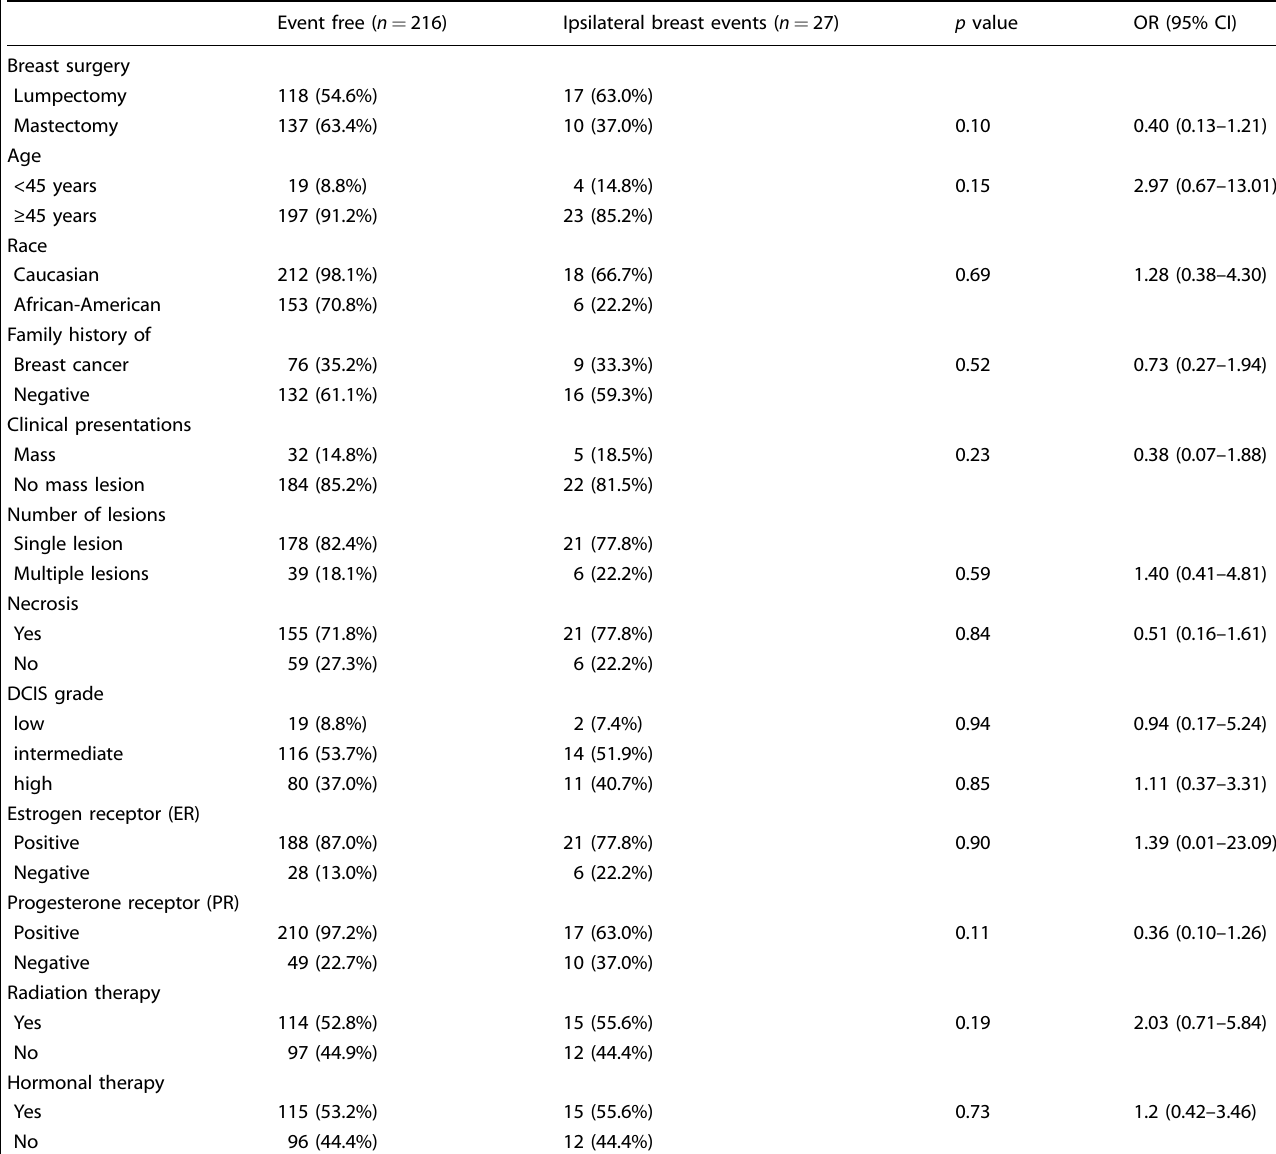
Table 2. Clinical and pathological characteristics of patients with DCIS who developed Ipsilateral breast events after at least 5 years